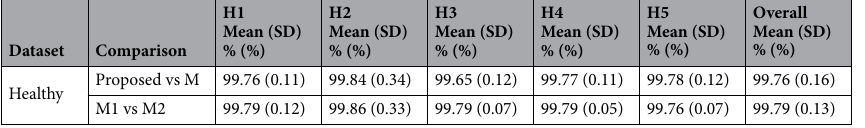
Table 1. Evaluation of automated CIB detection; Notation: M1 manual segmentation-1, M2 manual segmentation-2, M average of M1 and M2, SD standard deviation, H1 to H5 represents datasets 1 to 5 (100 B-scans per dataset).